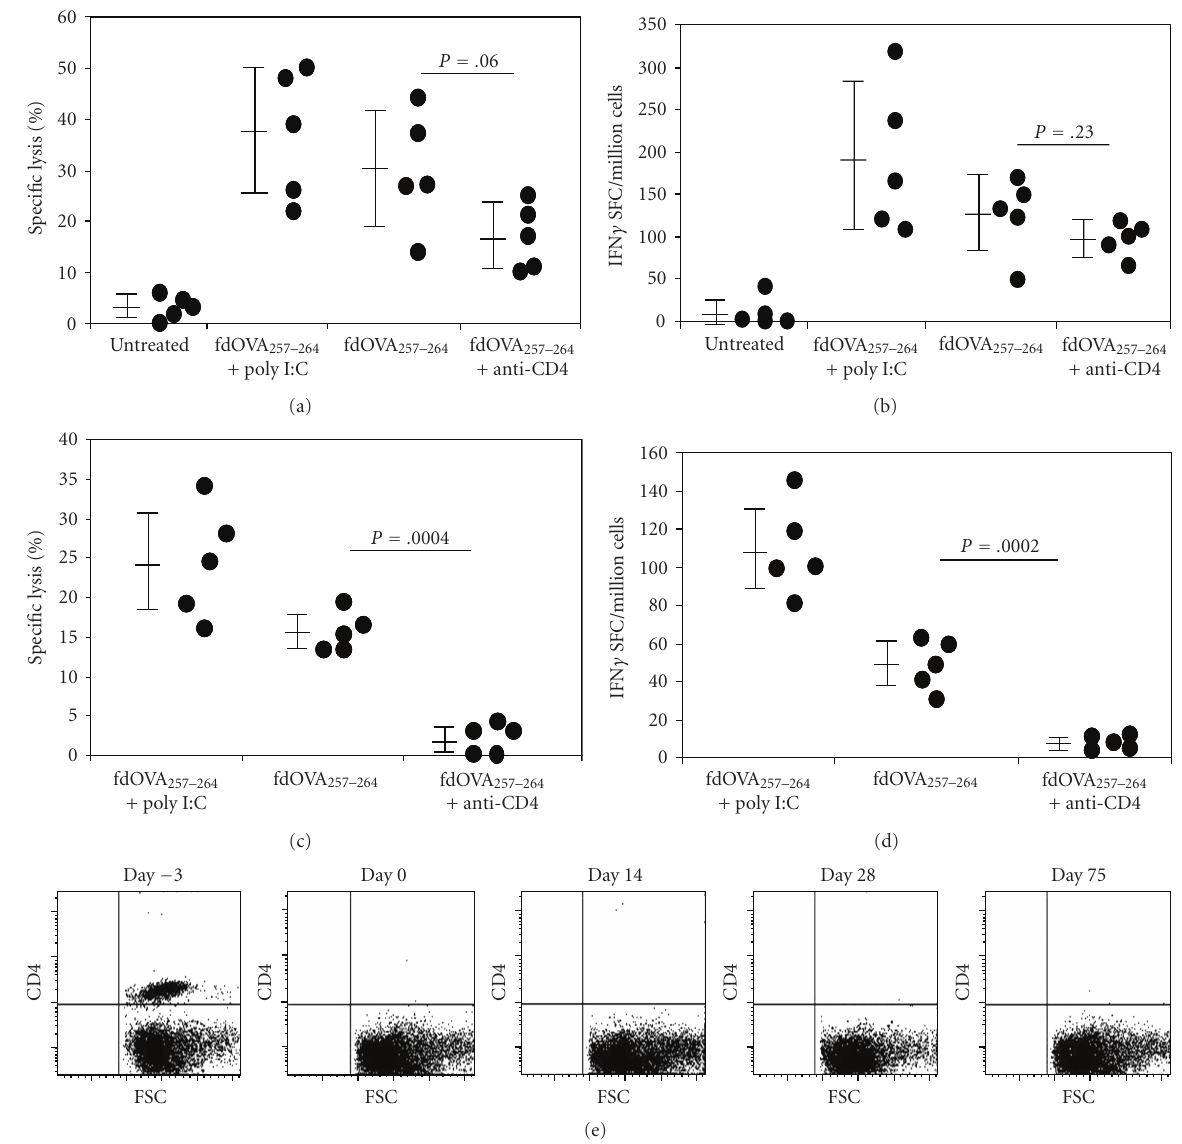
Figure 2: CTL and IFN- γ responses in mice immunized with fd bacteriophage particles in the presence or in the absence of CD4+ T cell help. Mice were immunized by two injections with either fdOVA 257–264 plus poly I:C or fdOVA 257–264 particles as indicated in Materials and Methods. Immunizations with fdOVA 257–264 particles were also performed in mice depleted of CD4+ T cells by treatment with GK1.5 mAb. CTL and IFN- γ productions were assayed after 15 days (a, b) or after two months (c, d) from the last injection. Each symbol represents data obtained from a single mouse. The mean value ± SD for each group is reported. (e) CD4+ T cell depletion was analyzed by cytofluorometry using noncompeting anti-CD4 antibody. The analysis was performed on spleen cells isolated from mice sacrificed at the time points